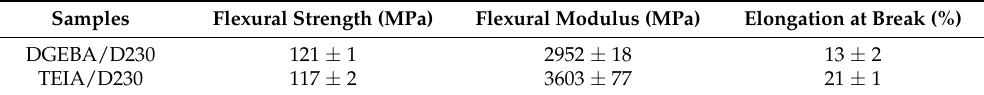
Table 5. Flexural properties of cured EP resins with D230 curing agents.